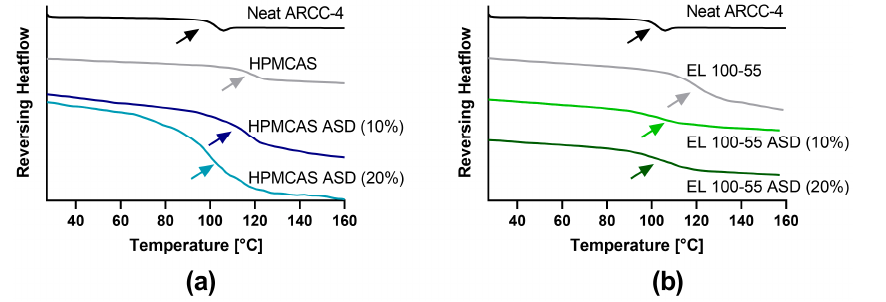
Figure 5. DSC thermograms (exo up) of ( a ) HPMCAS ASDs (10 and 20% drug load) and ( b ) EL 100-55 ASD (10 and 20%) compared to neat ARCC-4 and neat polymers.